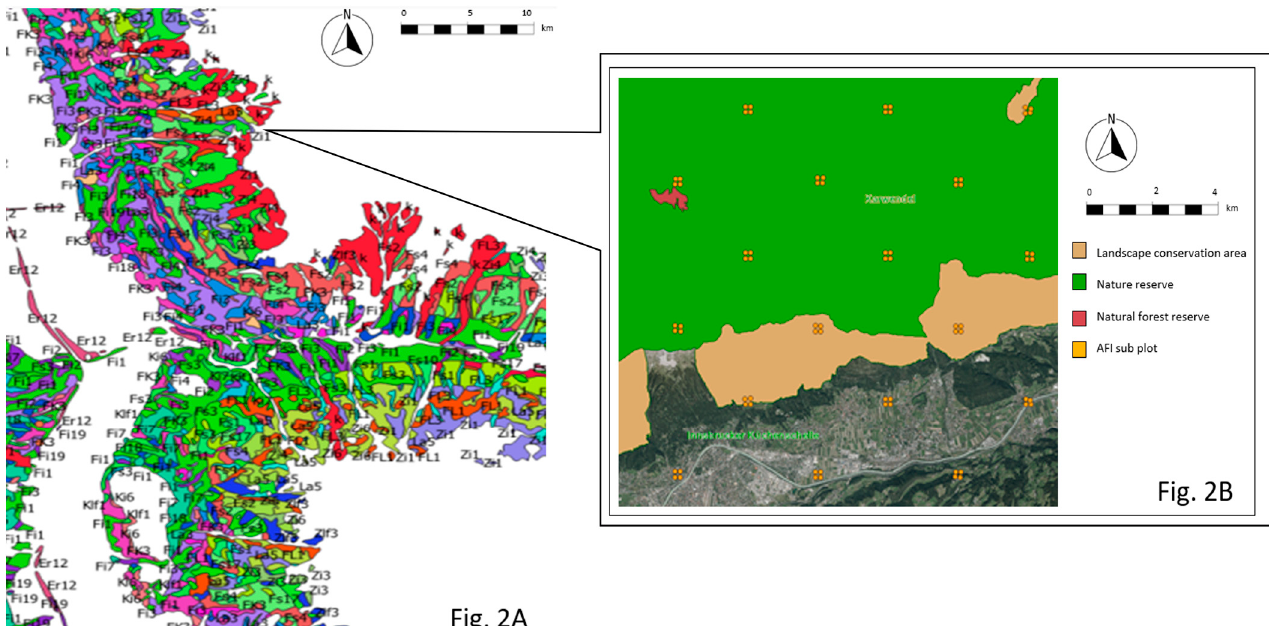
Figure 2. Processing inventory data with QGIS (47°24 ′ 59.99 ″ N, 11°27 ′ 59.99 ″ E). ( A ) Excerpt of the QGIS forest typing [53]. Different colors and abbreviations indicate the forest types. ( B ) Forest typing data (e.g., beige and green objects) is overlaid with TIRIS (e.g., orthophoto), AFI (orange dots), and reference area (red polygon) data.